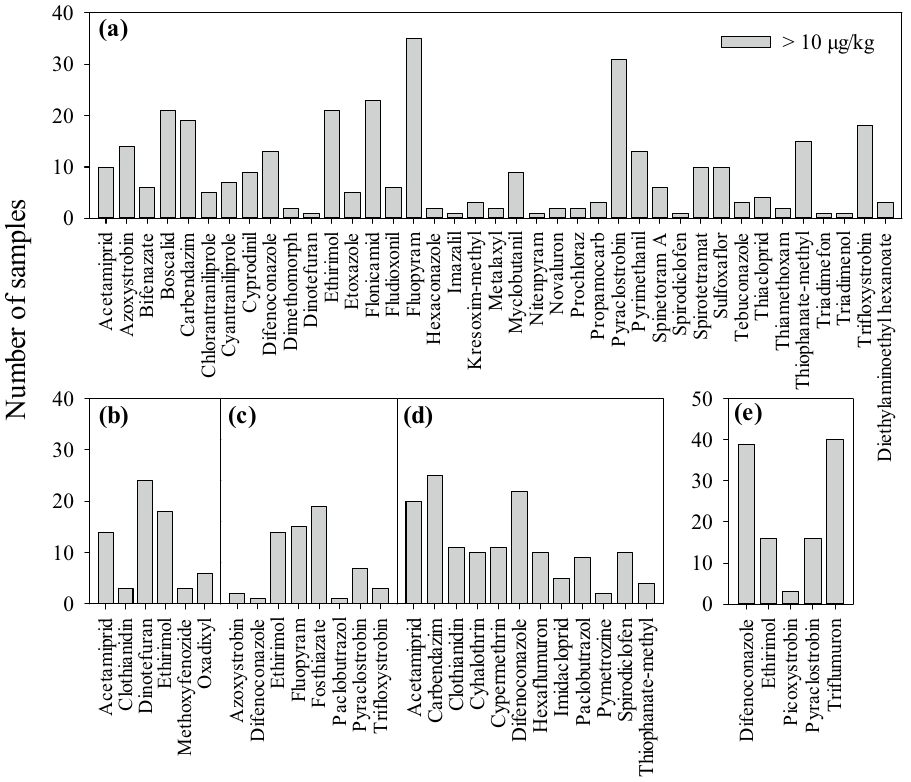
Figure 2. Number of samples with different pesticide residues in strawberries ( a ), watermelons ( b ), melons ( c ), peaches ( d ), and grapes ( e